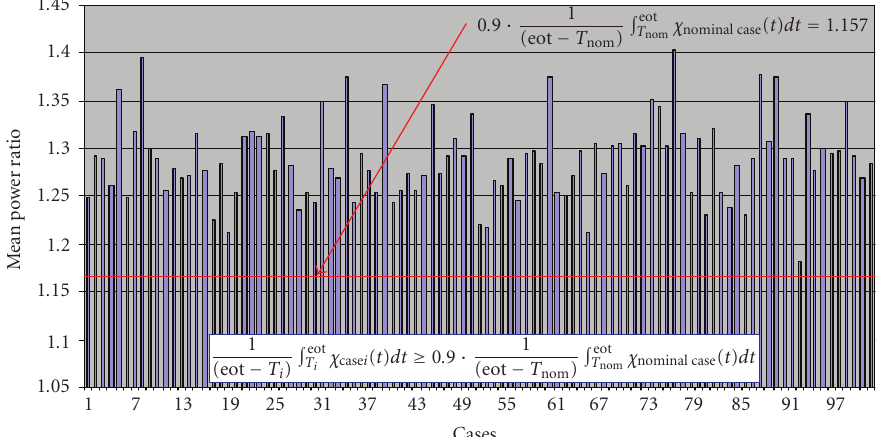
Figure 10: Transient performance indicator—2 results (long